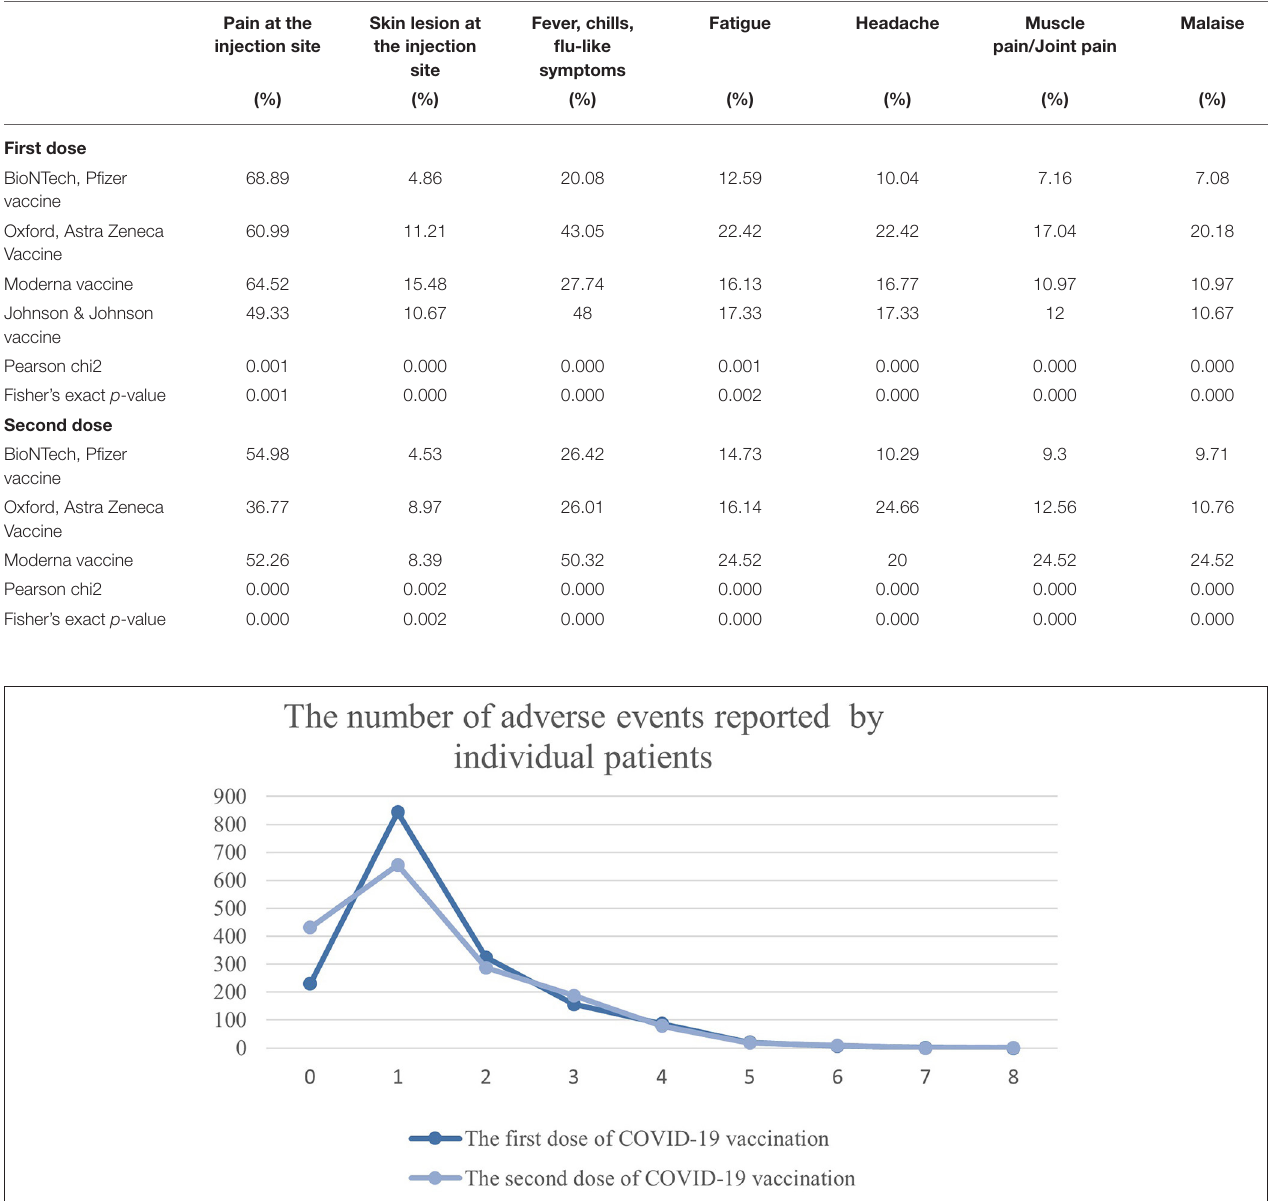
TABLE 2 | The proportion of most common side effects after particular vaccines administered among the